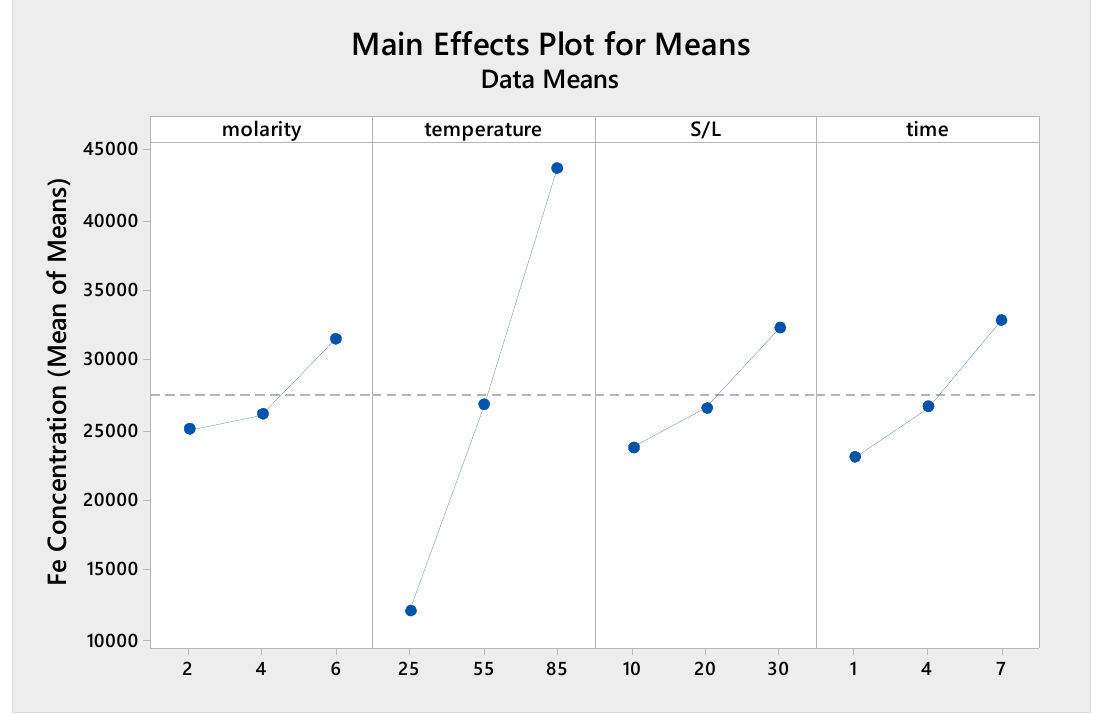
Figure 3. Effects of each parameter (( A ) Acid molarity, ( B ) Temperature, ( C ) Solid-to-Liquid ratio (S/L), and ( D ) Leaching time) associated with their levels on Fe concentration. Minerals 2019 , 9 , x FOR PEER REVIEW